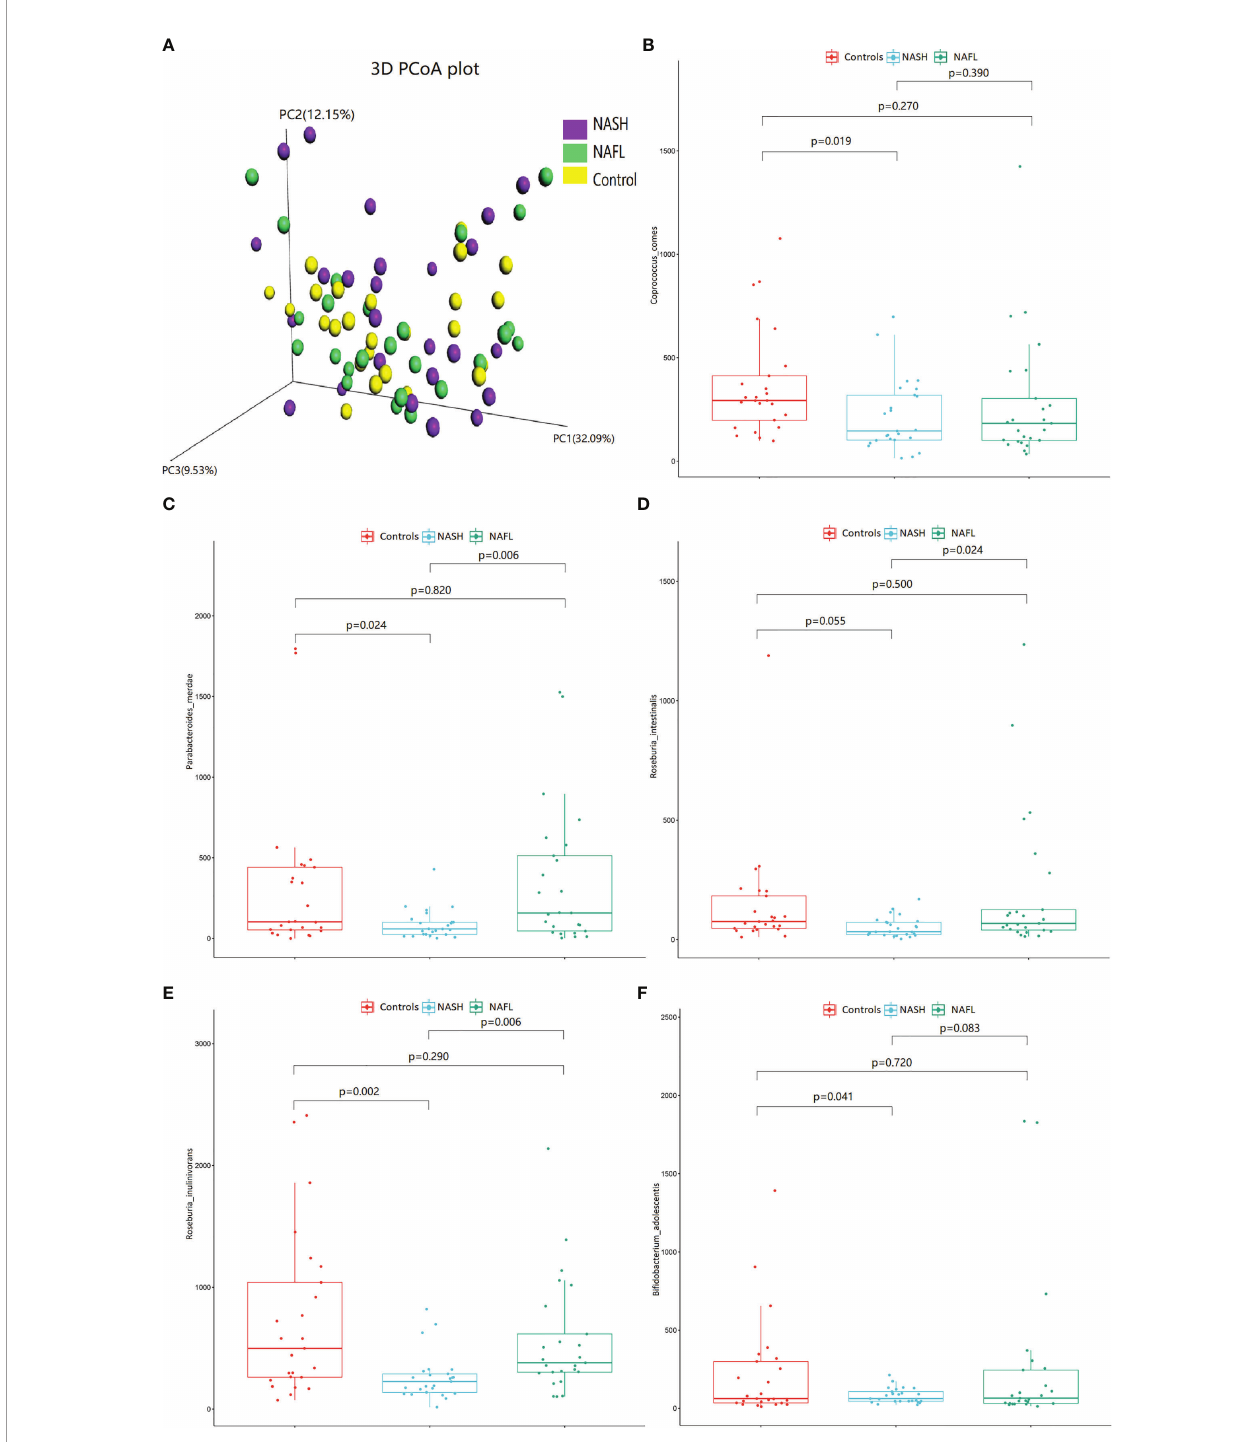
FIGURE 2 | The 3D PCoA plot and scattered dot plot of gut microbiota species in different groups. Unweighted UniFrac 3D PCoA plot (A) , PC1 represents one principal component, PC2 and PC3 represent other principal components, and percentage represents the contribution of principal components to sample differences. Each point in the fi gure represents an individual, and samples in the same group are represented by the same color. Coprococcus_comes (B) , Parabacteroides_merdae (C) , Roseburia_intestinalis (D) , Roseburia_inulinivorans (E) , and Bi fi dobacterium_adolescentis (F) . The scattered dot plot of gut microbiota species in different groups are shown. NAFL, nonalcoholic fatty liver; NASH, nonalcoholic